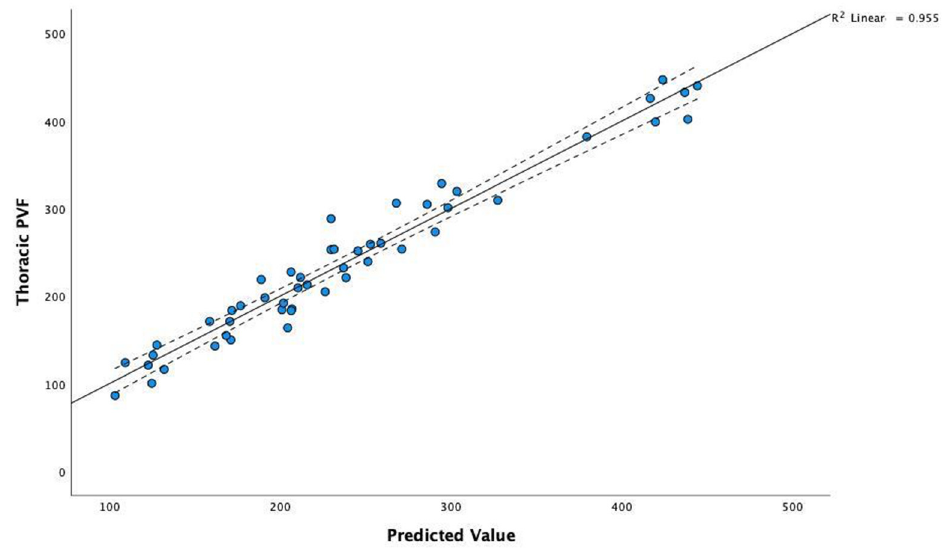
Figure 1. Correlation scatterplot of thoracic PVF for the observed values and those predicted by the model.